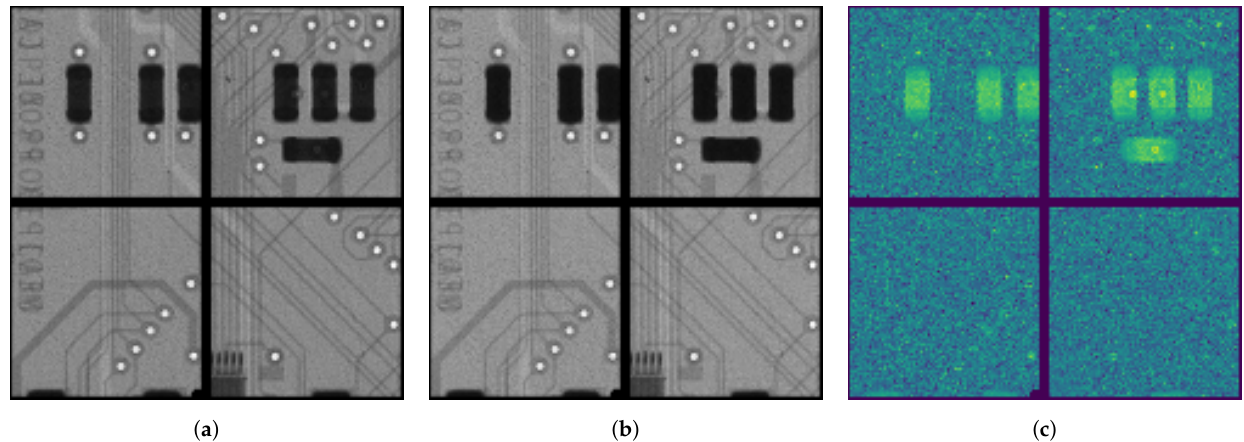
Figure 9. Spectral radiographs of a Medipix 2 board taken with a 2 × 2 tiled HEXITEC array and a white X-ray spectrum from a microfocus lab source set to a tube voltage of 50kV. Integration time of the flatfield and sample images is 2min, and the source flux was set to keep the flatfield pixel occupancy close to 6% for a flatfield flux of 2.8 × 10 5 and 1.2 × 10 5 phs − 1 cm − 2 through the sample. The CdTe HEXITEC was configured with a bias voltage of 300V, and a bias refresh of 5s every 30s. The peltier cooling was set to a 20°C setpoint. ( a ) 1keV interval below the Ba K-edge. ( b ) 1keV interval above the Ba K-edge. ( c ) Difference image highlighting the location of